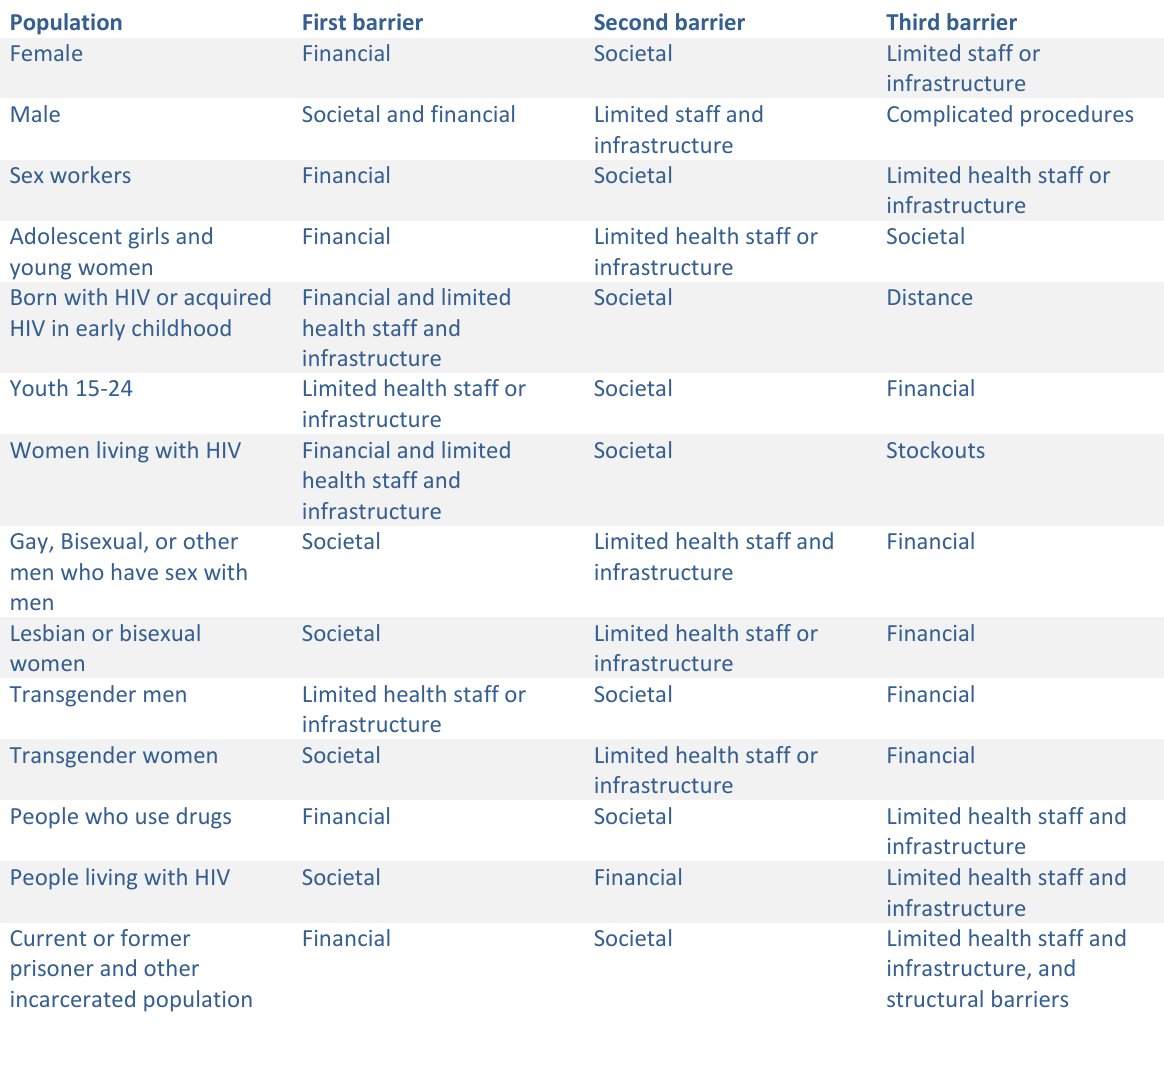
Table 4. Top three barriers to accessing health services, by population